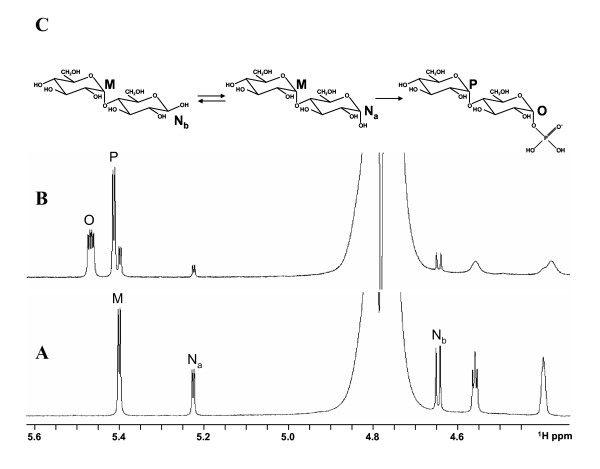
1H-NMR spectra of the Mak reaction. Mixture contained 5 mM each ATP and maltose, 5 mM MgCl2 in 10 mM BTP at pH 8, prior (A) and after (B) the addition of 15 μg of Mak and incubation for 10 min at 37°C. The top panel (C) represents the structures of maltose and maltose-1-phosphate and is labeled according to their assigned resonances.